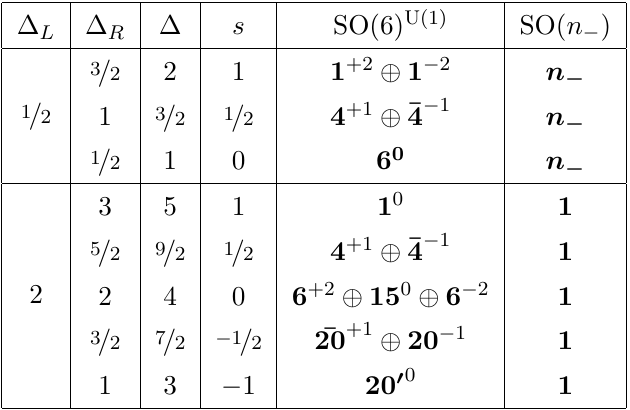
1 ; 1) solution with diagonal embedding (2.21b) and gauge j